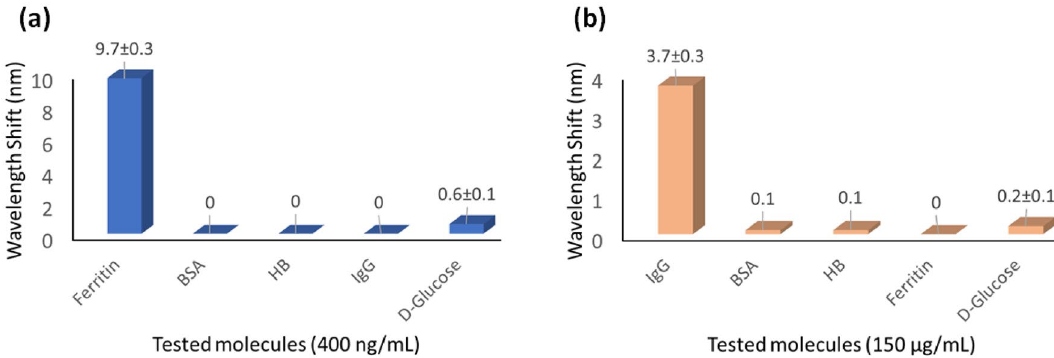
Figure 7. ( a ): Specificity analysis of Ab(Ft)/L-Cysteine/MoS 2 /OF-SPR biosensor; ( b ): Specificity analysis of Ab(IgG)/L-Cysteine/MoS